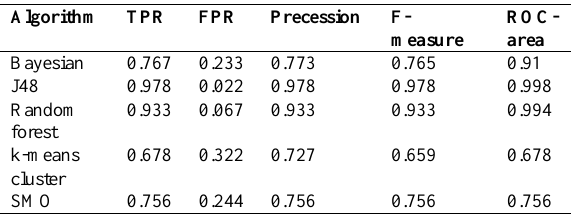
Table 5. Performance parameters measure (weighted average value) of different algorithms for total dataset.